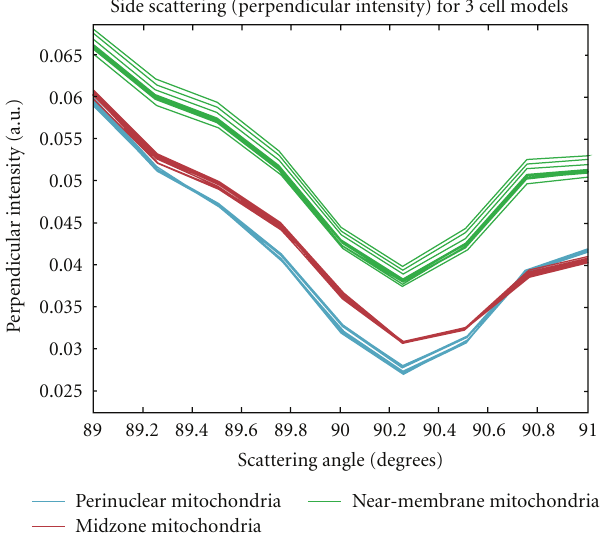
Figure 6: Scatter plot of the i 2 forward scattering intensity versus the i 2 side scattering intensity for the 10 realizations of each of the 3 di ff erent mitochondria distributions. This plot clearly shows the di ff erentiation between the cases and spread of each